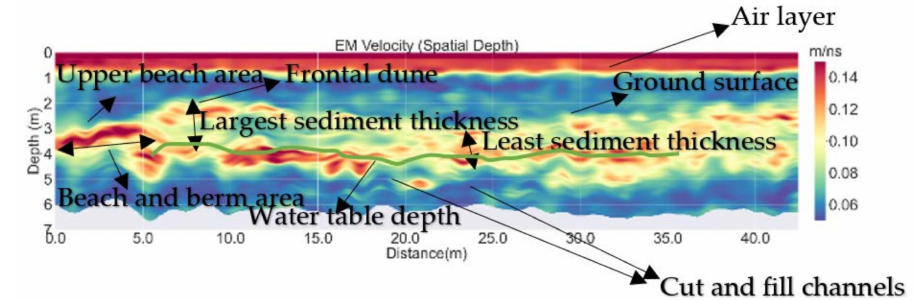
Figure 13. The subsurface EM velocity map in the depth domain for Old Bar Beach, NSW, Australia. To further check the robustness of our DCNNs in forward and inverse modeling, the selection of two traces was made at different offsets from Figure 12a to compare them with the associated traces in the processed field GPR data shown in Figure 12b, and the matching results are presented in Figure 14a,b. For the GPR traces at 2.53 m and 13.32 m offset, the R 2 values are 0.74 and 0.68, respectively.